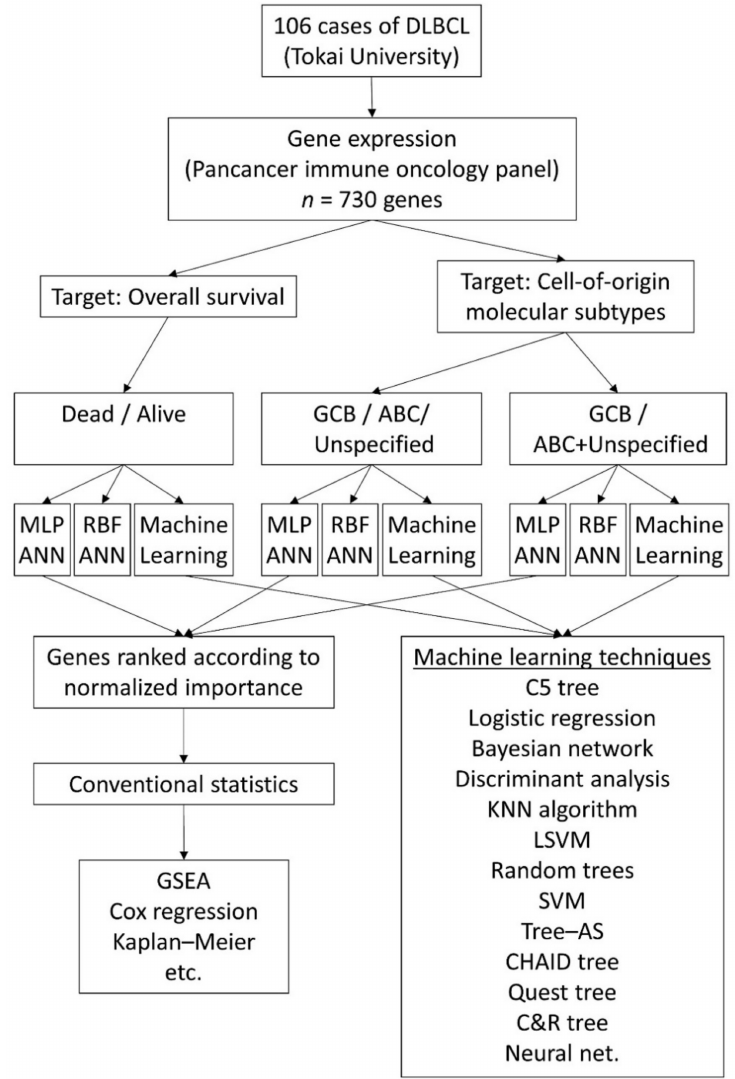
Figure 5. Data analysis workflow. This research used the gene expression data of 106 cases of DLBCL from Tokai University. The gene set was composed of 730 genes from the pancancer immune profiling panel. Two types of artificial neural network were used: multilayer perceptron (MLP) and radial basis function (RBF). Besides these, other machine learning techniques were included in the analysis in addition to conventional statistics.